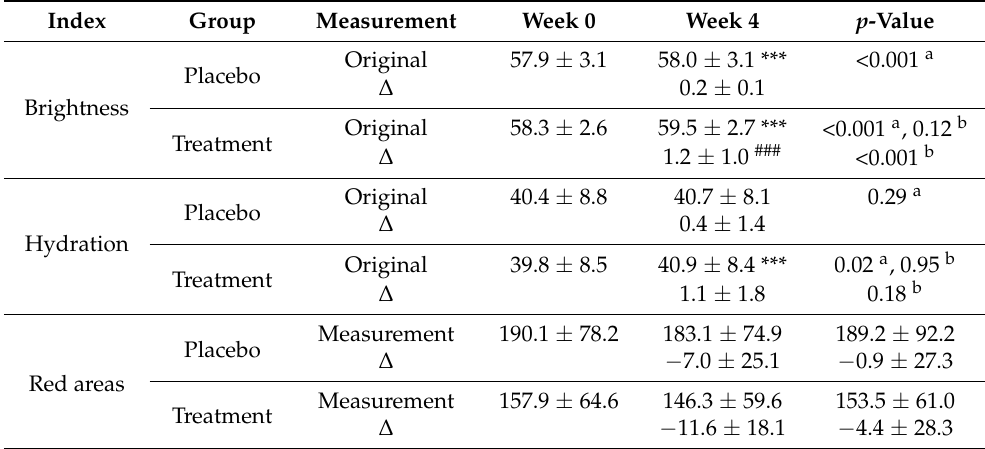
Table 4. Measurement of skin brightness, skin hydration, and red areas in the subjects (mean value ±